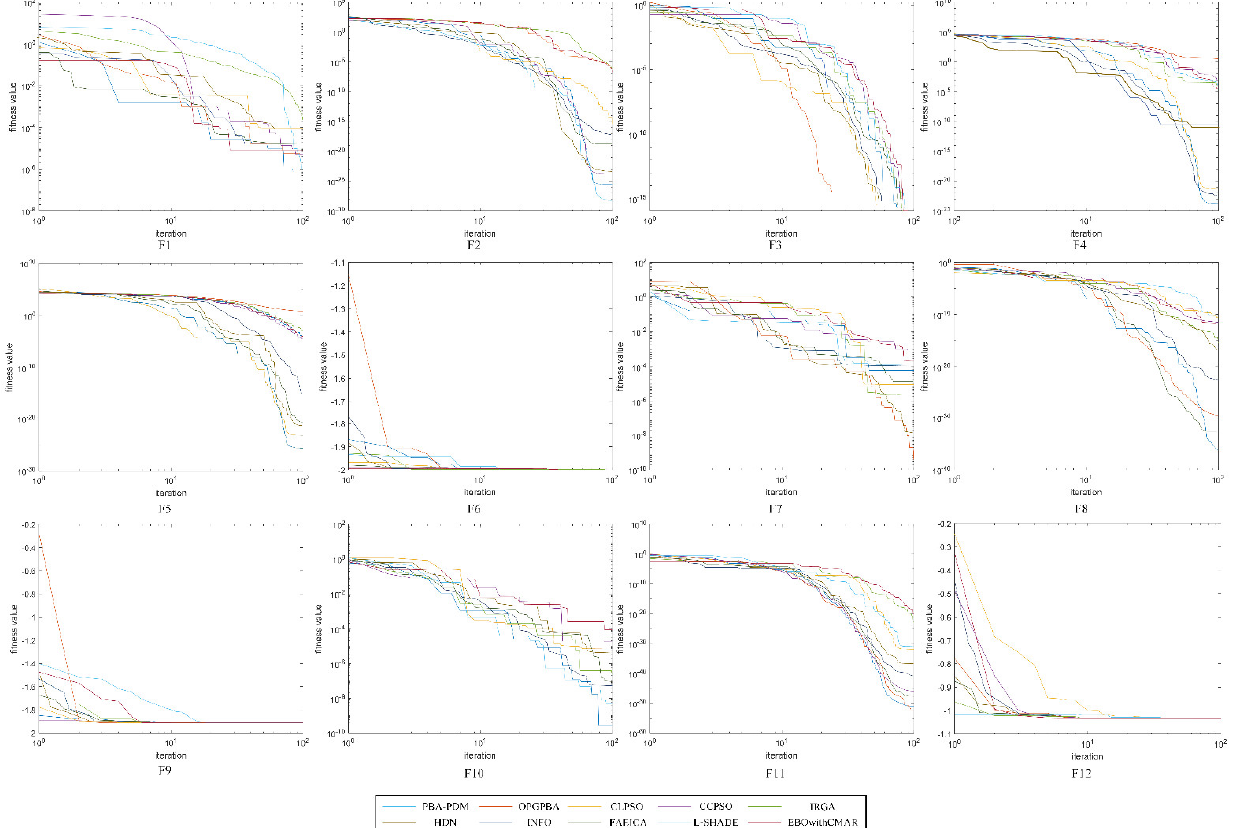
Figure 9. Convergence curves of the multimodal function. Table 4 shows the obtained results for PBA-PDM compared with other optimizers in tackling the UM functions. Table 5 shows the obtained results in dealing with the MM functions. Note that the best results in the comparison for each test function are shown in